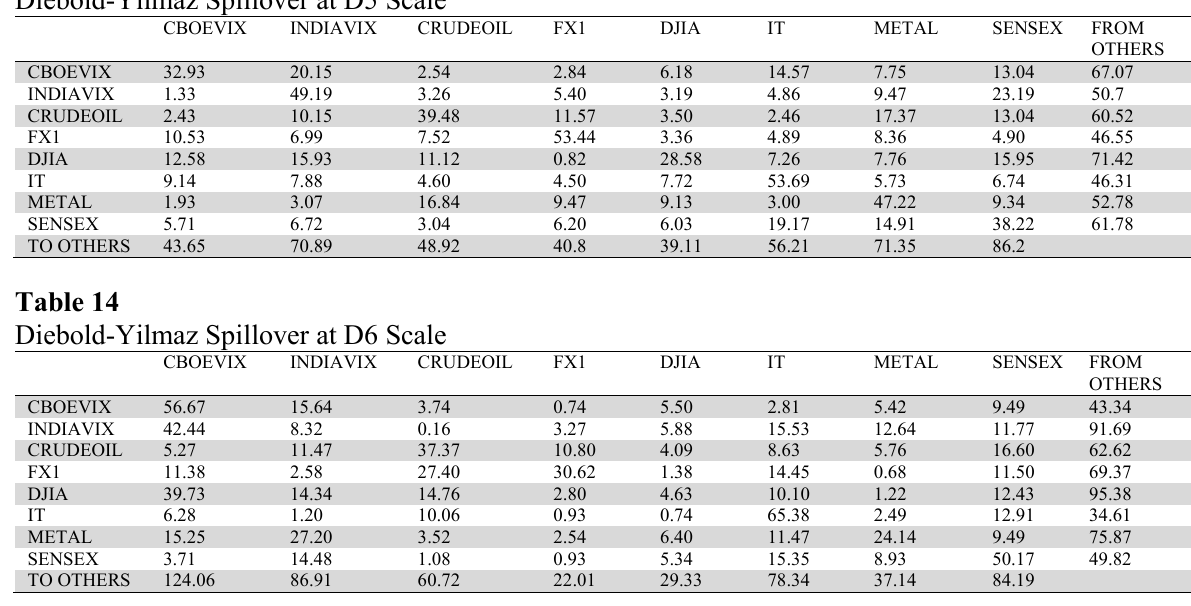
Diebold-Yilmaz Spillover at D5 Scale CBOEVIX METAL SENSEX FROM CBOEVIX